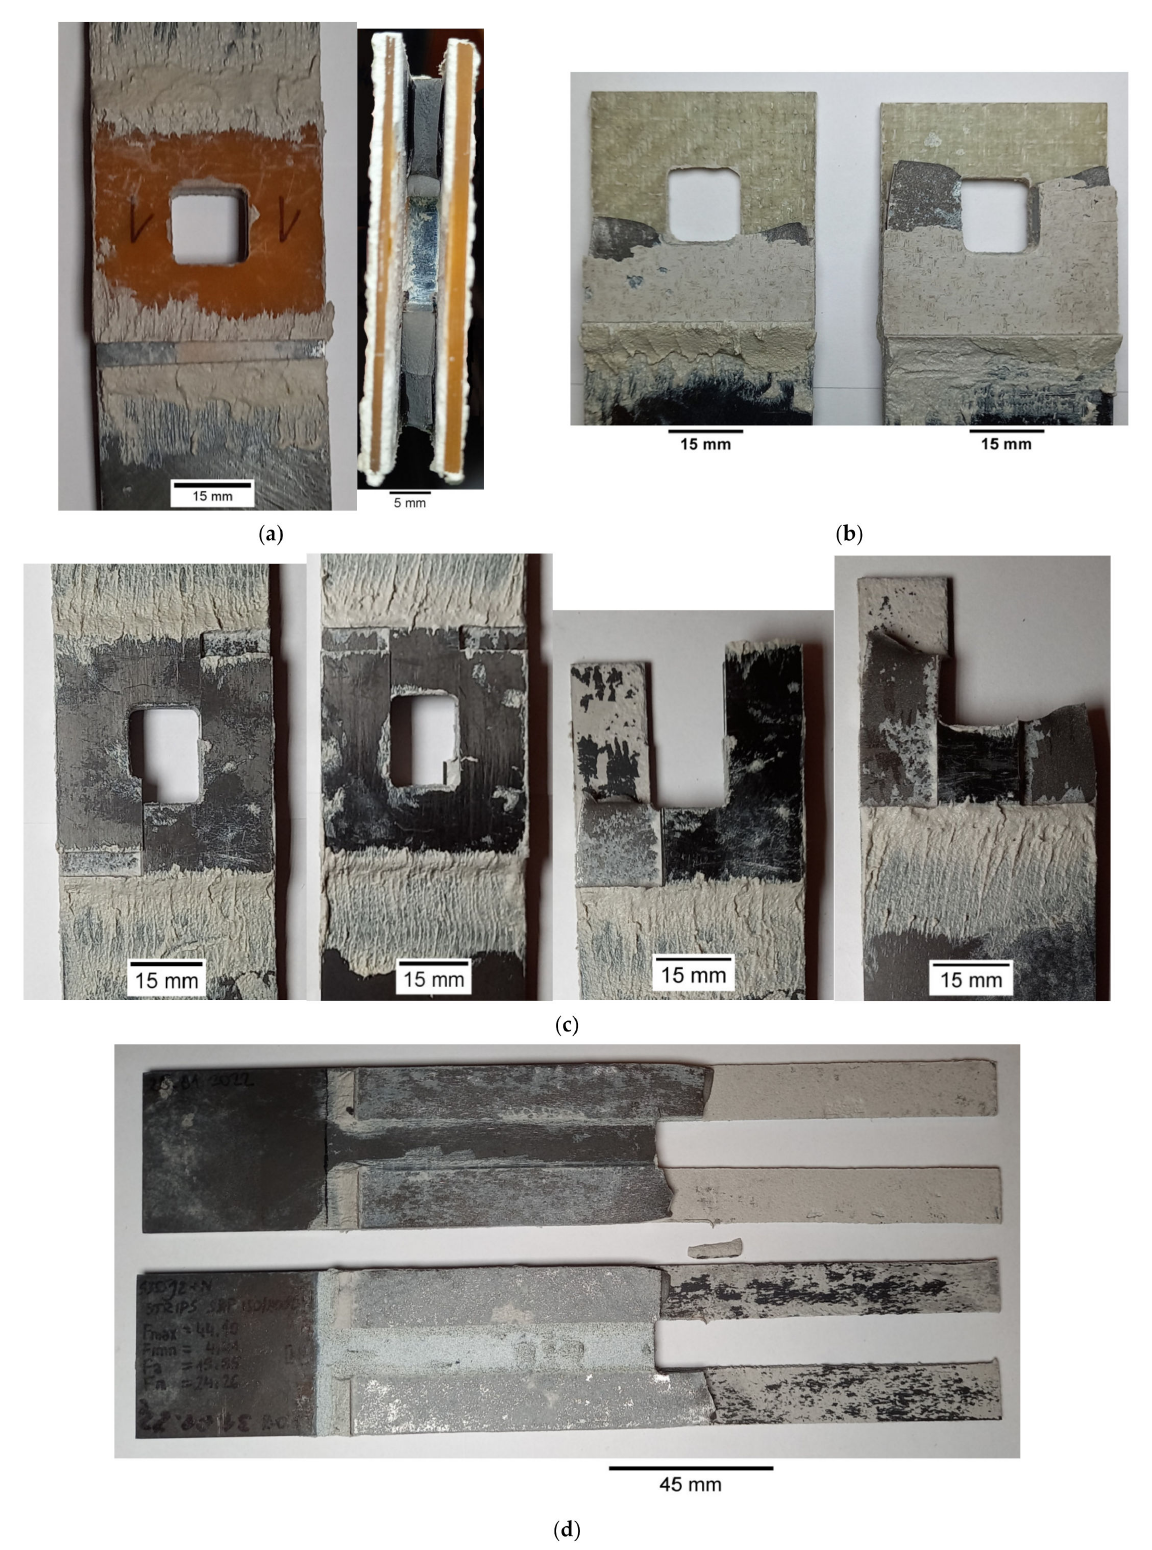
Figure 23. Failure modes of samples with composite overlays: ( a ) no. 19—Hexcel TVR 380 [+45 ◦ / − 45 ◦ ] 4 ; ( b ) no. 20—E-glass woven roving; ( c ) no. 21—S&P C-Laminate 150/2000—45 × 45 mm; ( d ) no. 22—S&P C-Laminate 150/2000—15 × 180